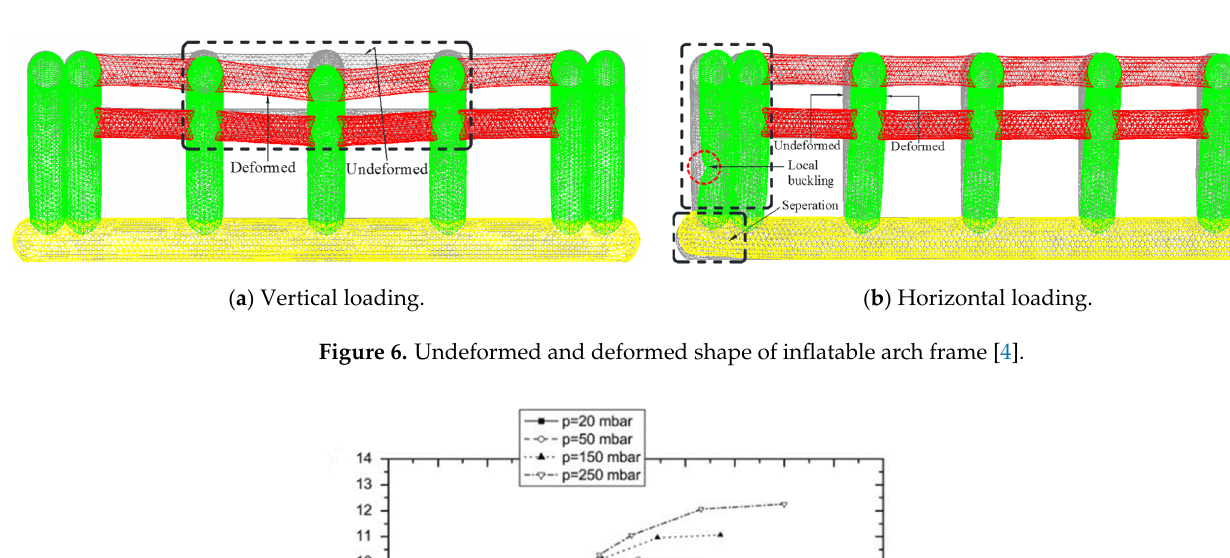
Figure 5. Air beam load–displacement curve [40].